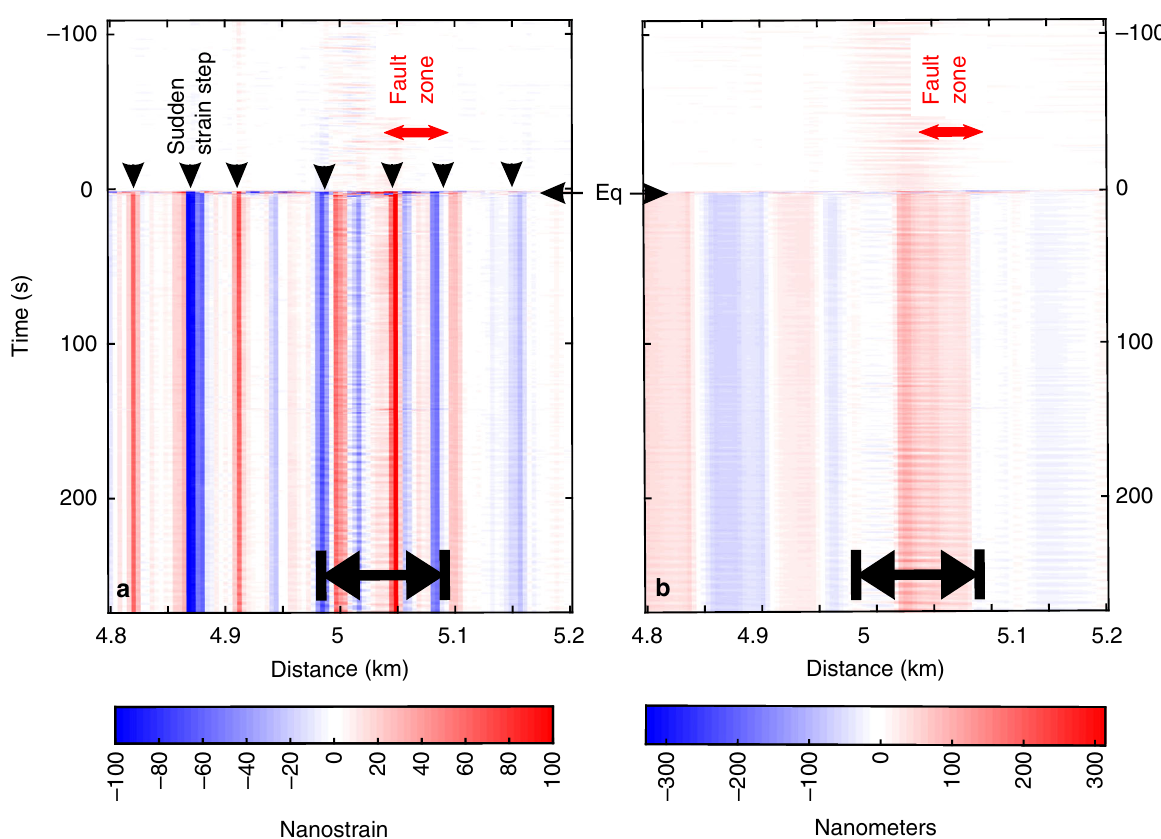
Fig. 8 Dynamics of a fault damage zone within an active geological rift. a Extensive record (400 s) of strain observed in the vicinity of the damage fault zone, from 100 s before, during and 300 s after the earthquake (Figs. 6 and 7). Sudden strain steps (black arrows indicated at the time 0) occur over several neighbouring traces simultaneously to the waves of the earthquake. Strain remains with the same value for at least 300 s, possibly more. The location of the steps correspond to locations of geological features observed in the fi eld, e.g. faults. b Displacement computed by spatial integration at selected traces along the same section of the cable as in Fig. 7a and c. The displacement is directly obtained from the spatial integration of the strain in a over a 60-m-long sliding window. Eq: